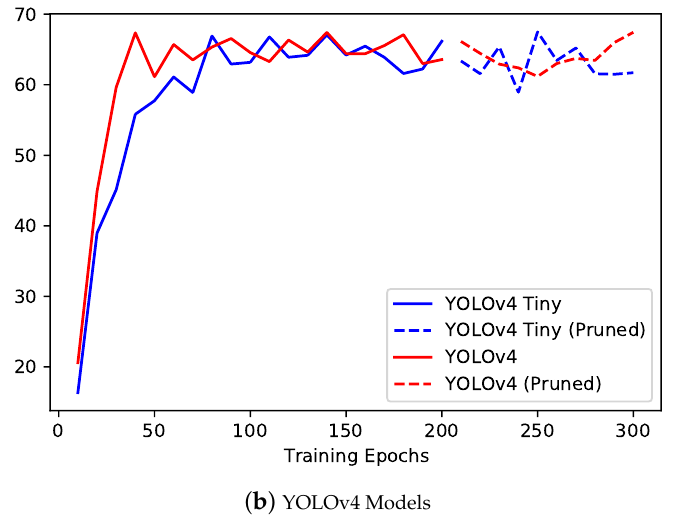
Figure 8. Training mAP curves for the different variants of computer vision object detection models implemented for plastic-bag contamination Detection.